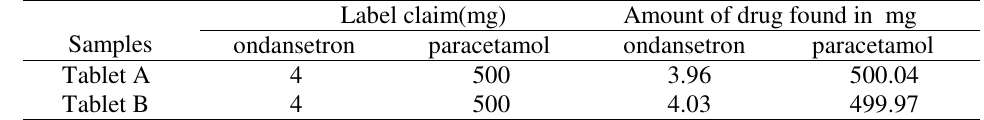
Table 1. Results of analysis